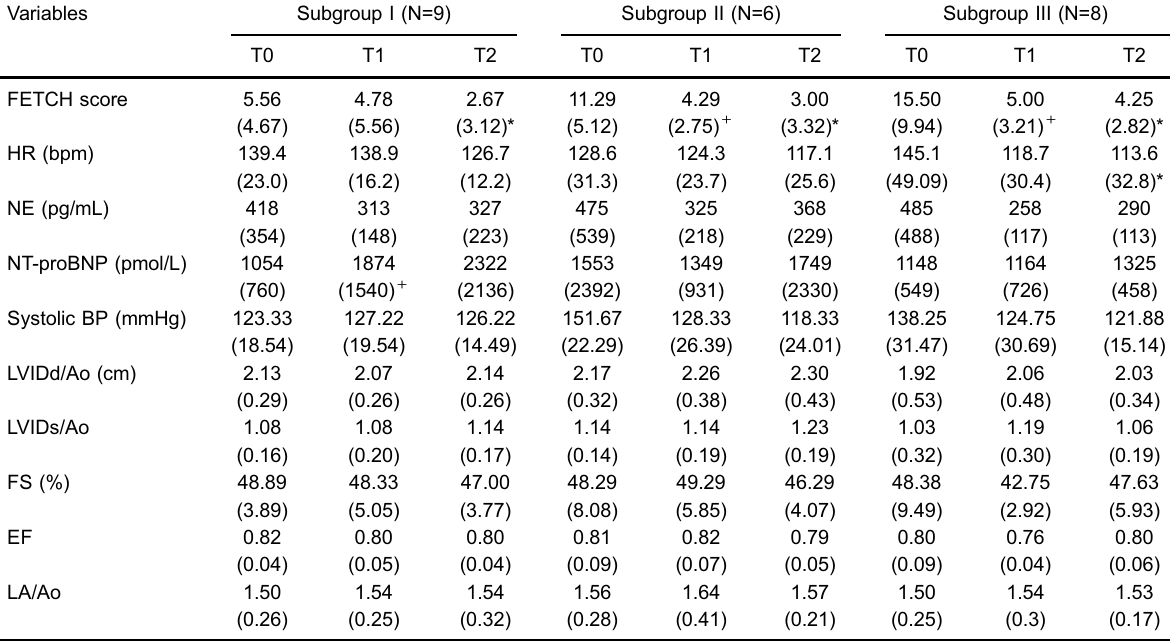
Table 3. Clinical, laboratory, and echocardiographic values for the 3 subgroups at the three evaluation